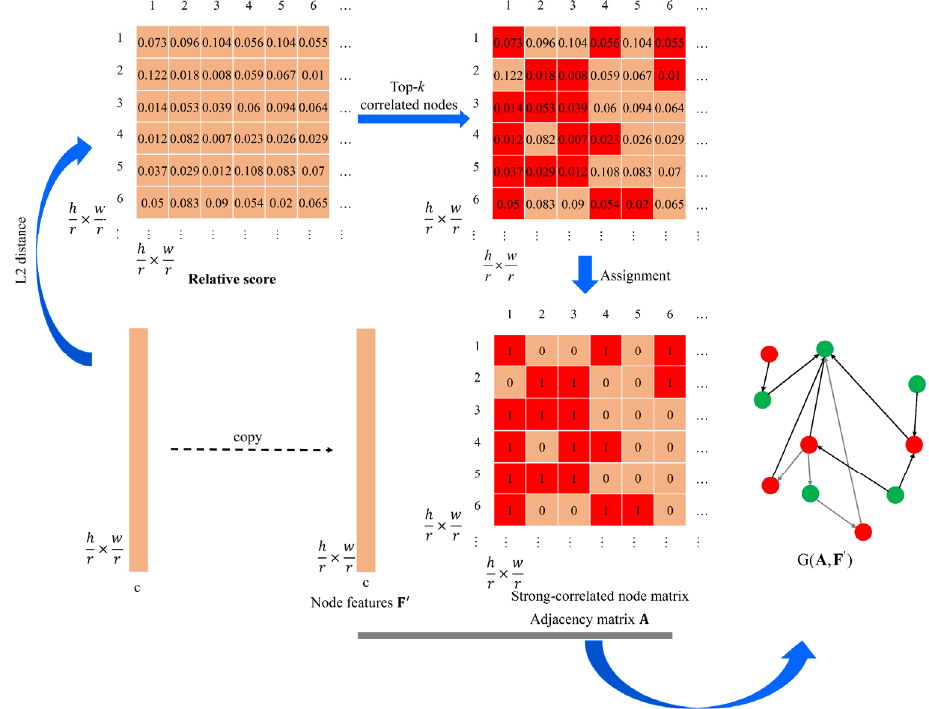
Figure 4. Graph definition layer. The context structure is extracted by the top- k selection strategy based on L2 distance. For a pixel i , the pixels with the top- k highest relative scores are selected (i.e., red elements in Line i in the distance matrix). The selected k pixels in different spatial positions constitute the context structure of Pixel i .